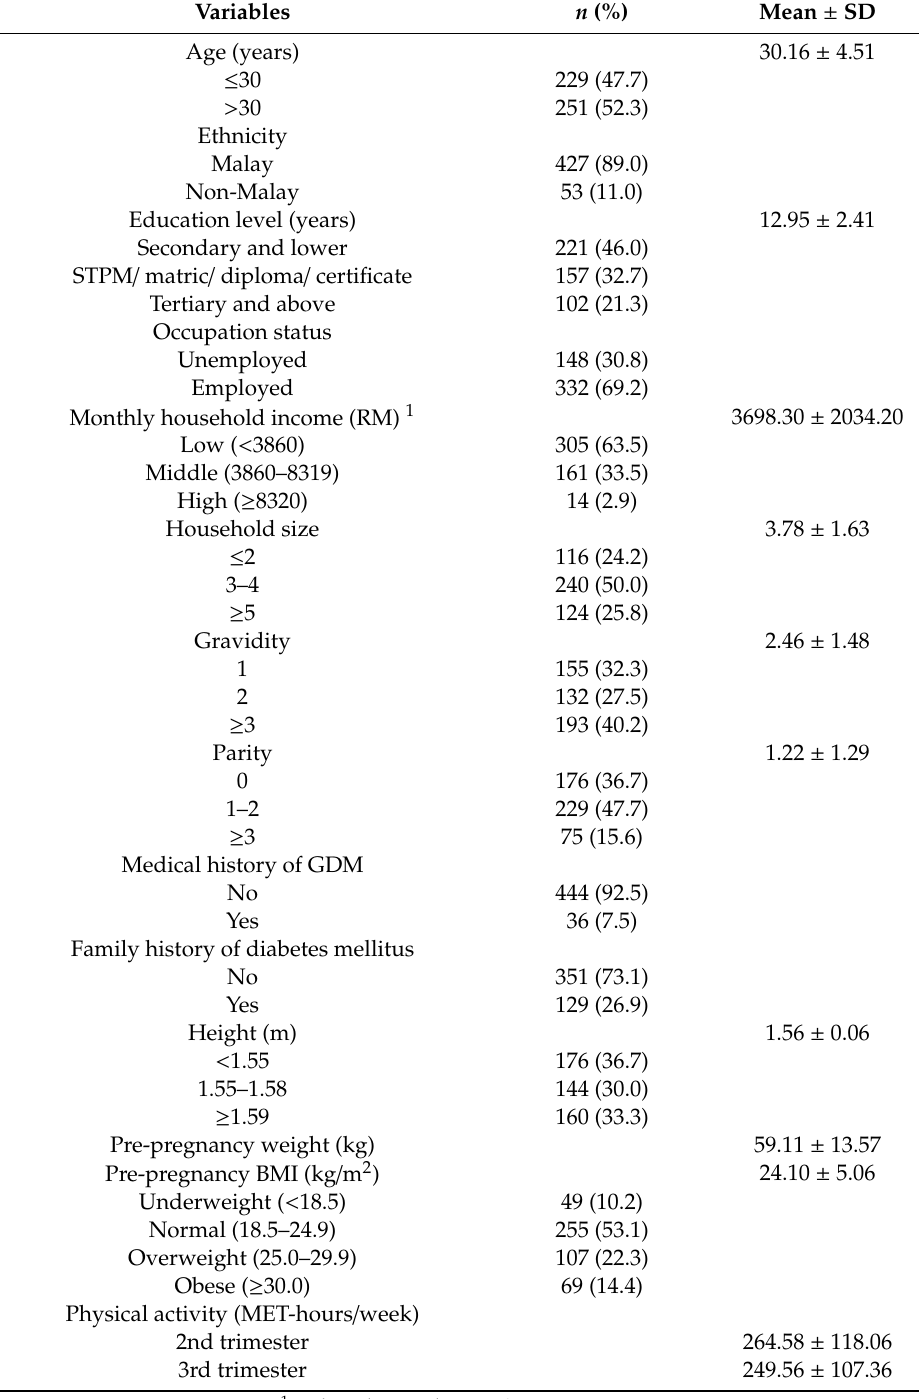
Table 1. Characteristics of women ( n =